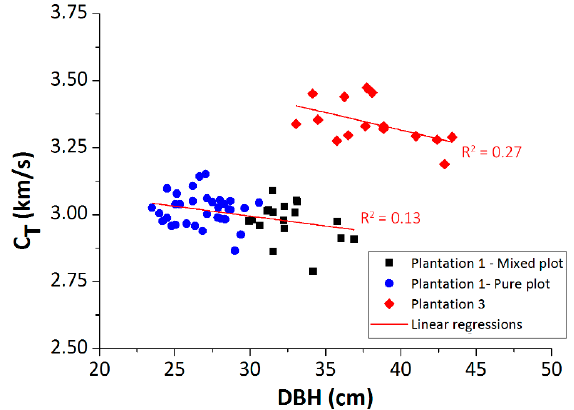
Figure 8. Propagation velocity versus DBH; Plantation 1—Walnut and Poplar sector (Southern Spain) (black square); Plantation 1—Poplar sector (blue circle); and Plantation 3 (Northern Spain) (red diamond). Table 4. Average values of DBH and propagation velocity for Plantations 1 (Southern Spain) and Plantation 3 (Northern Spain).